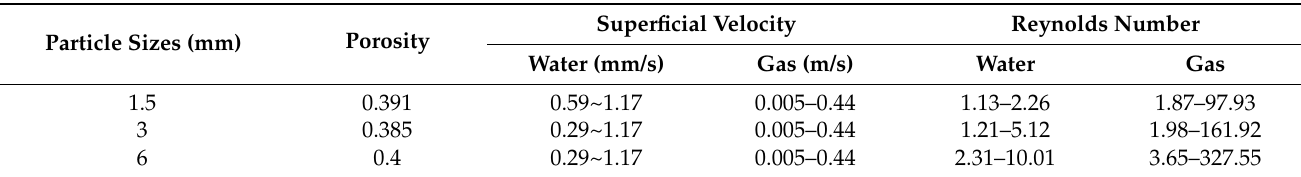
Table 1. Details of experiment setup.